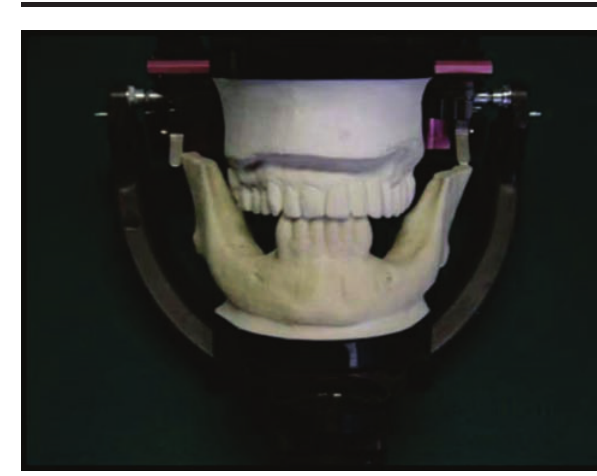
FIGURE 7 – Dentulous model transferred to the